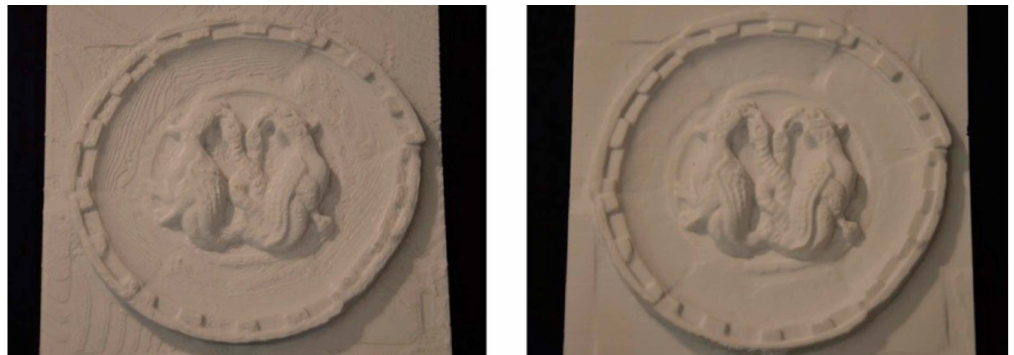
Figure 2. Di ff erent quality of replica due to the slicing orientation of the model on the printing plate. ( left ) Longitudinally with evident traces of layers; ( right ) diagonally, without traces of